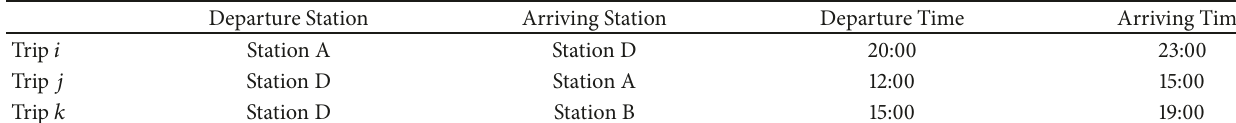
Table 1: Basic information of the sample.